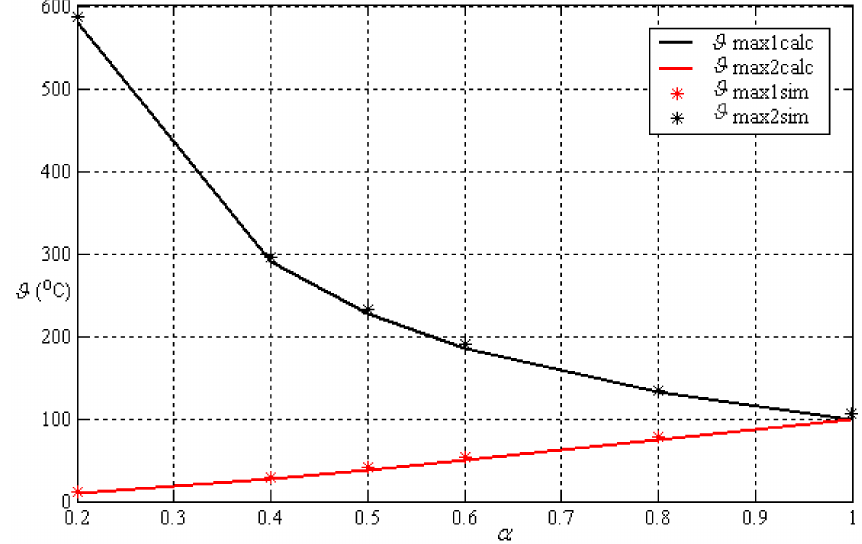
Figure 8. Maximum temperature rise variation at different assymetrical coefficient values. Comparison between computed ( ϑ max 1 calc , ϑ max 2 calc ) and simulated values ( ϑ max 1 sim , ϑ max 2 sim